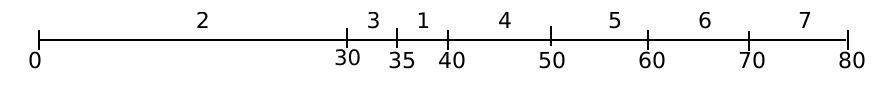
Figure 2. Complementary ED-schedule S 1 for Example